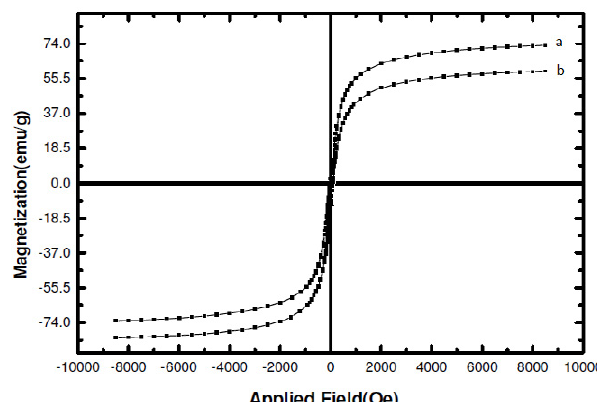
O and b) Fe O @SiO nanostructures 3 4 3 4 2